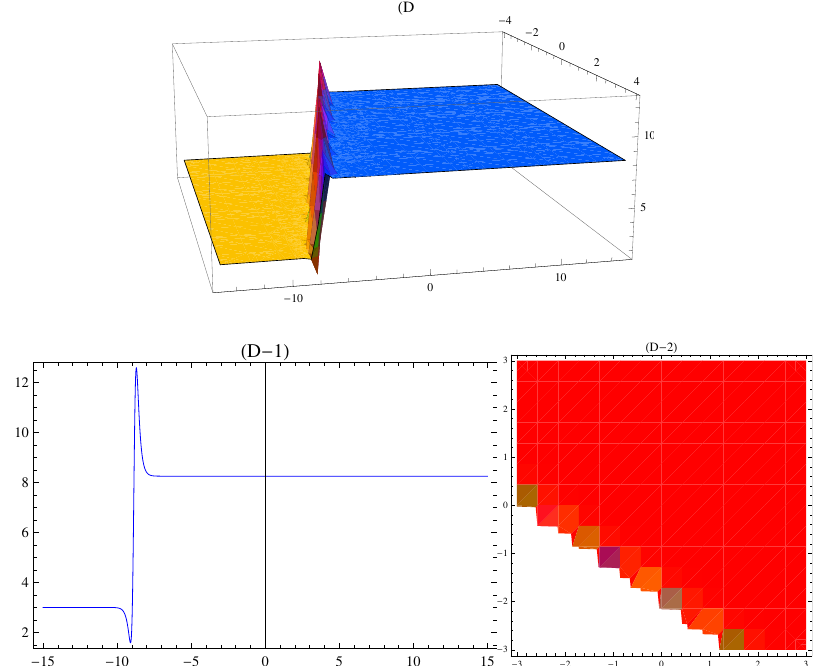
Figure 4: (D) 3D graph of (40) with α = 2.2 , 𝛾 = 1.4 , θ = 2.3 , λ = 3.3 , µ = 1.7 , w = 2 , p = 0.98 , q = 0.95 , k = 2 , A = 2.6 , b = 2 , δ = −2 , ς = 2 , τ = 0.82 , c = 3.1 , z = 3 , χ = 1.8 , ϵ = 1.9 , y = 2.7 . (D-1) 2D plot of (40) with t = 1 . (D-2) Contour graph of (40).